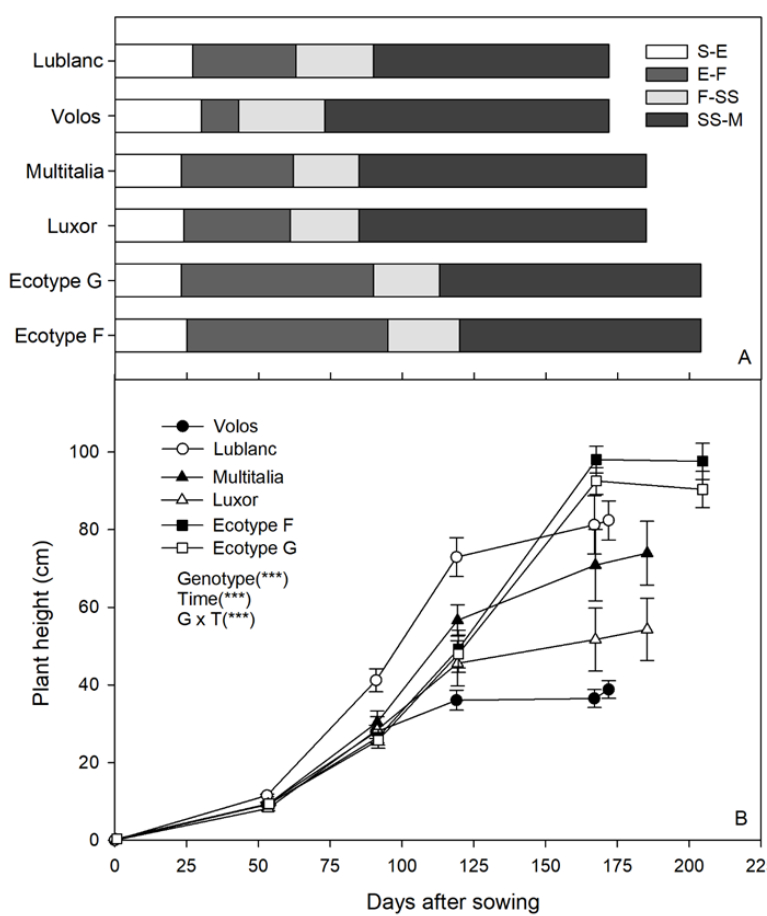
Figure 3. Main growth stages ( A ) and plant height ( B ) of six white lupin ( Lupinus albus L.) genotypes. Growth stage intervals: sowing-emergence (S-E), emergence-flowering (E-F), flowering-seed setting (F-SS), seed setting-seed maturity (SS-M). Effects statistically significant at p ≤ 0.001 (***). Plant height was also different among genotypes and it was significantly affected by the time (Figure 3B). Generally, there were no significant differences among genotypes at 100 DAS (on average, 32 cm), except for Lublanc (~10 cm taller). Lublanc was the tallest genotype